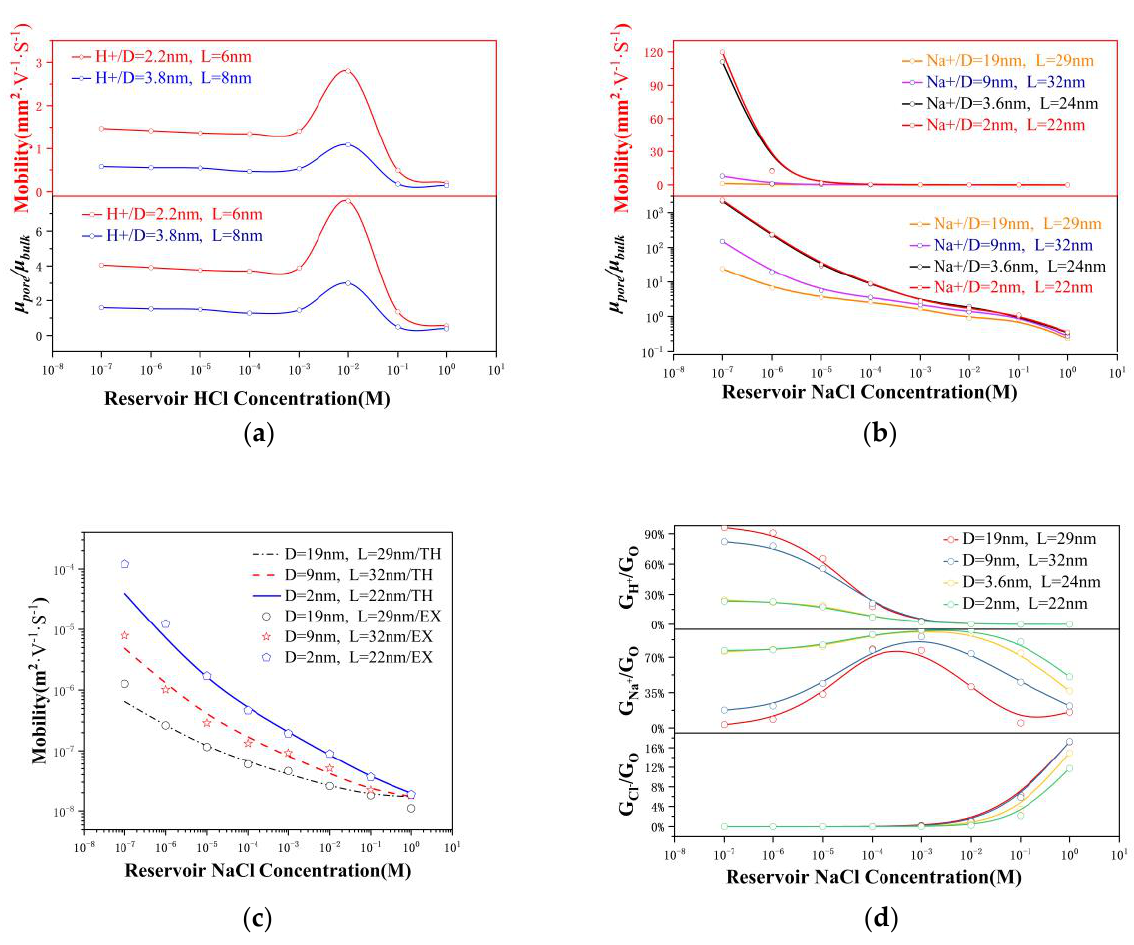
Figure 5. Ion mobility and selectivity. In ( a , b ), ion mobility and ratio of ionic mobility inside the nanopore ( 𝜇 𝑝𝑜𝑟𝑒 ) to the corresponding bulk mobility ( 𝜇 𝑏𝑢𝑙𝑘 ) as a function of reservoir concentration. ( c ) Mobility-concentration curves from various experiments and the mobility theory given in Equation (4). ( d ) Ion selectivity for the nanopore. Comparisons between the contributions of different ions to conductance. 𝐺 𝐻 + , 𝐺 𝐶𝑙 − , and 𝐺 𝑁𝑎 + are the H + , Cl − , and Na + conductances, respectively.